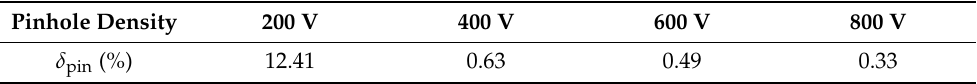
Table 5. Pinhole density of coated Nb layers at the various applied